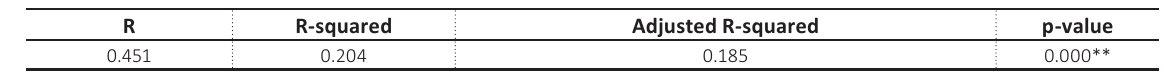
Table 12. Model summary